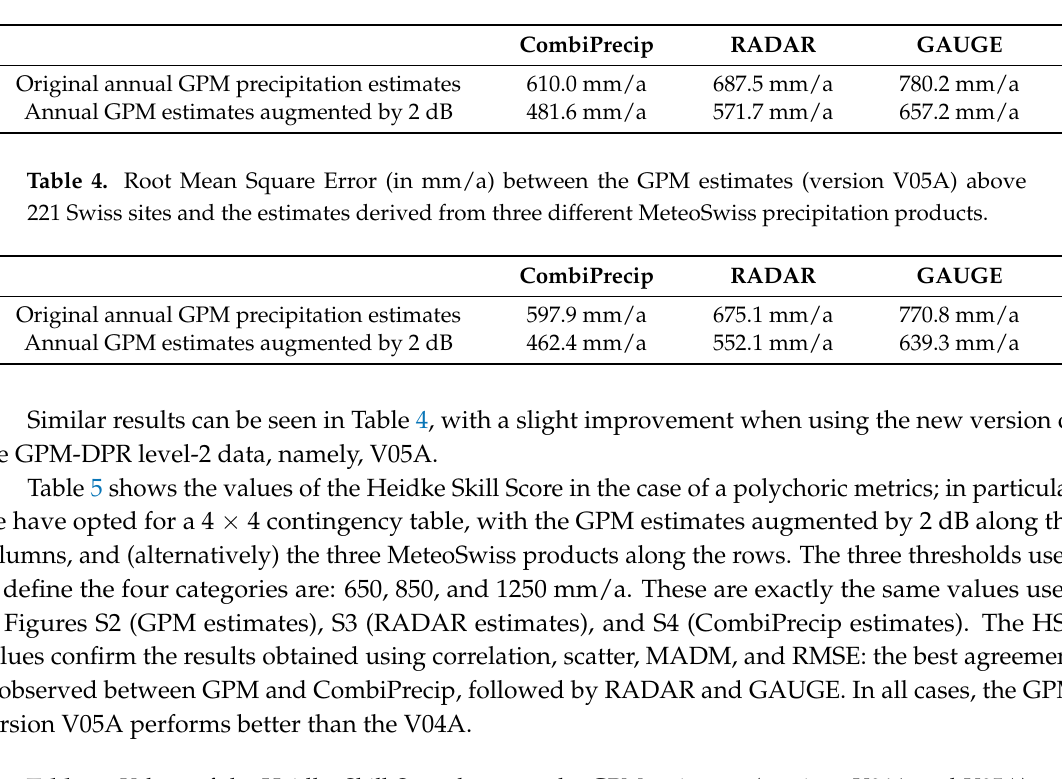
Table 5. Values of the Heidke Skill Score between the GPM estimates (versions V04A and V05A) augmented by 2 dB and the estimates derived from three different MeteoSwiss precipitation products above 221 Swiss sites. Four classes were used for deriving a 4 × 4 contingency table. The three thresholds used are: 650, 850, and 1250 mm/a (see also Figures S2–S4 in the Supplementary